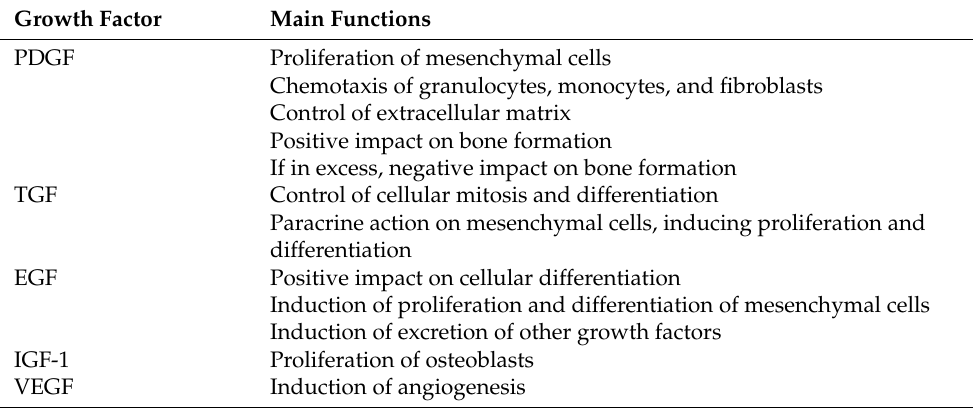
Table 1. Main growth factors deriving from platelets and their